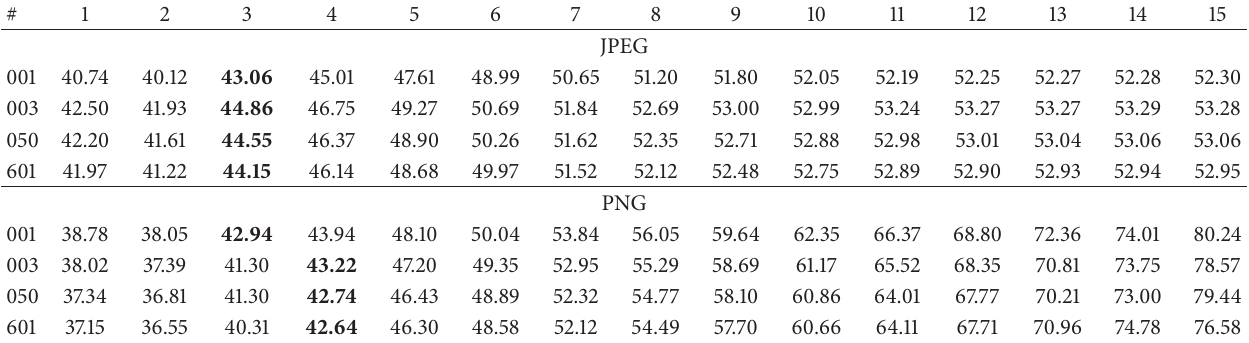
Table 6: PSNR results of proposed watermarking